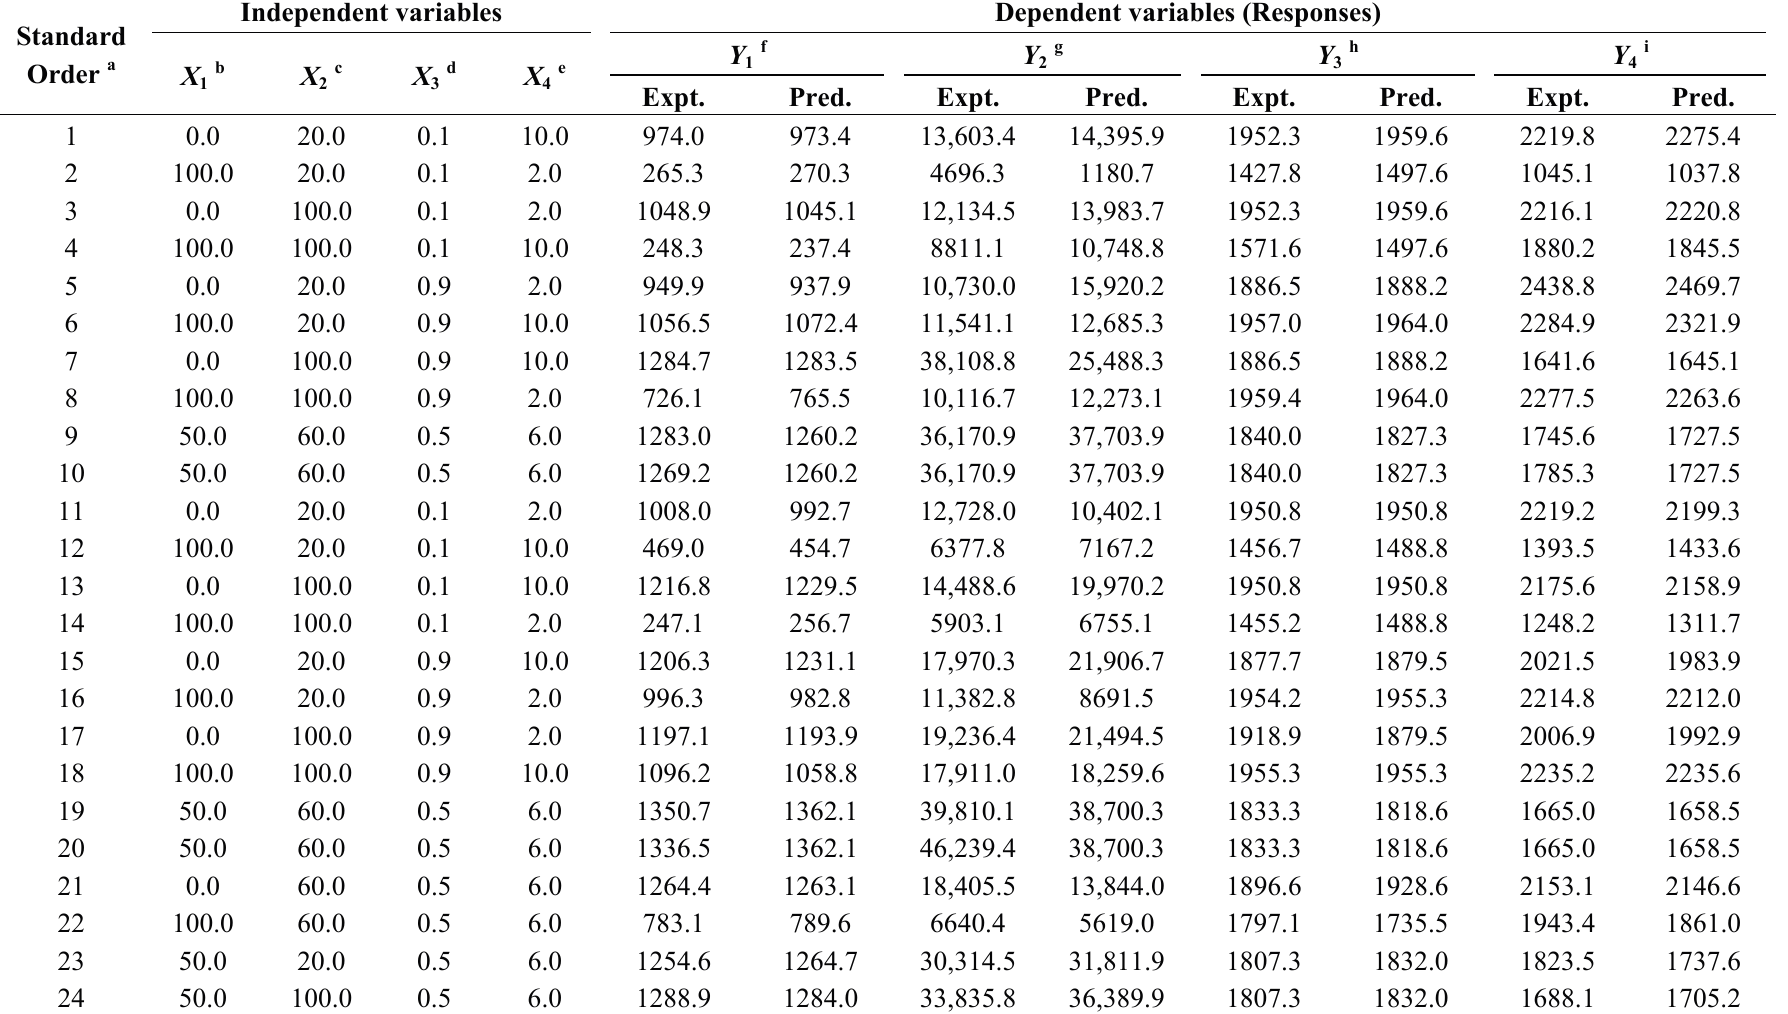
Table 1. Central composite design, experimental data (Expt.) and predicted values (Pred.) of the optimization of ultrasound-assisted extraction (UAE) conditions for the extraction of phenolic antioxidants from Orthosiphon stamineus